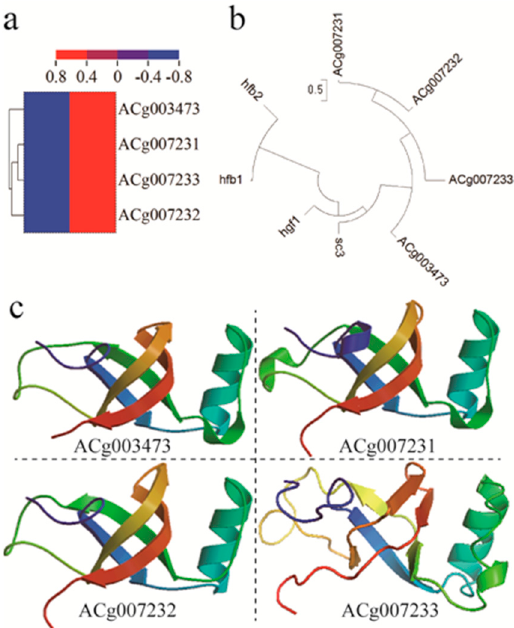
Figure 6. ( a ) A heatmap about differential expressions of four hydrophobin genes. ( b ) Their genetic relation with type I and type II was described by cluster analysis of amino acid sequences. ( c ) Their protein structure was also described using the SWISS-MODEL.